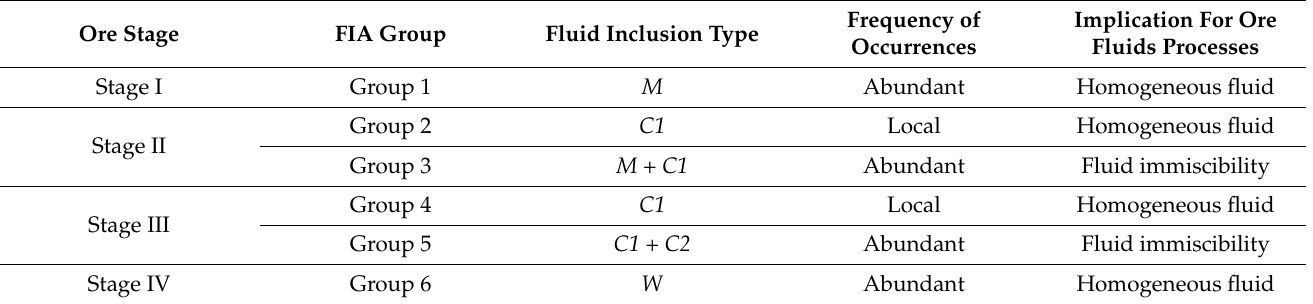
Table 1. Summary of the fluid inclusion and FIA groups in hydrothermal quartz from four mineral- ization